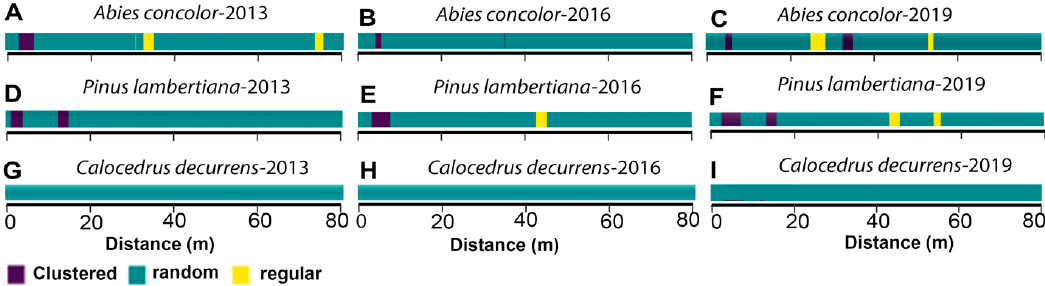
Figure 6. Spatial pattern of pre-fire (2013) and post-fire (2016 and 2019) large-diameter trees (live and dbh ≥ 60 cm) within the Yosemite Forest Dynamic Plot. Green, yellow, and violet colors show randomness, segregation, and clustering spatial patterns,